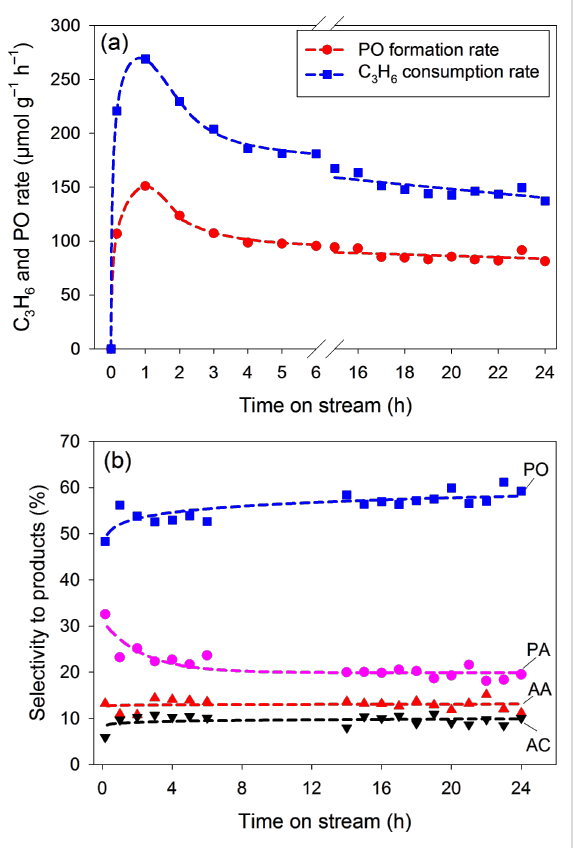
Figure 6: Time course of the photo-epoxidation of propylene with molecular oxygen under artificial sunlight (with an AM1.5G filter; 1.6 mW·cm − 2 ): (a) C 3 H 6 consumption rate and PO formation rate. (b) Selectivity to products. Lines are presented for guiding and are not based on a kinetic model.